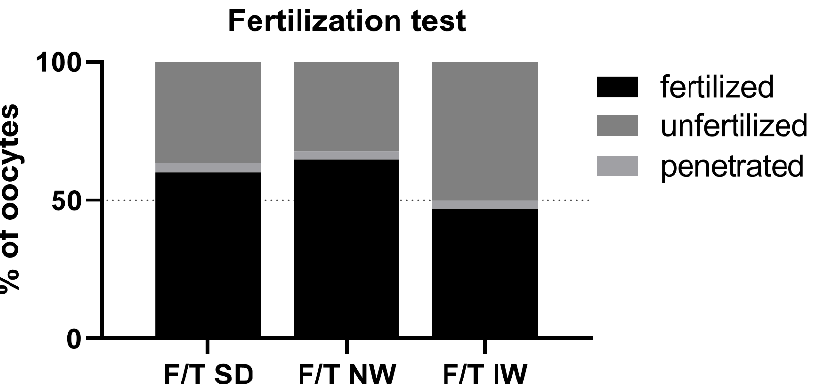
Figure 5. Penetration/fertilization test for each examined breed. F/T — frozen/thawed, SD — Slovak Dairy, NW — Native Wallachian, and IW — Improved Wallachian.